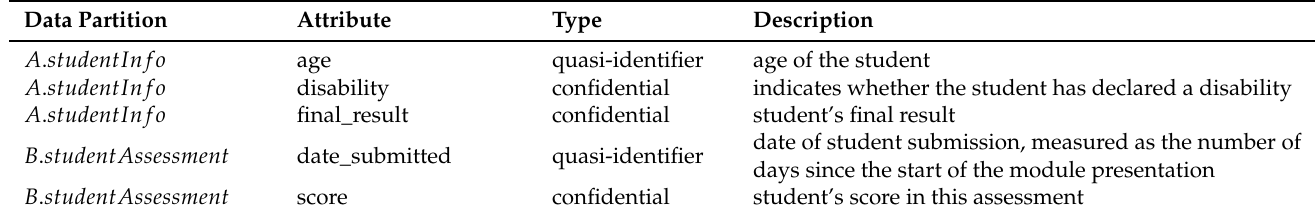
Table 4. Attributes of the data partitions held by P a and P b